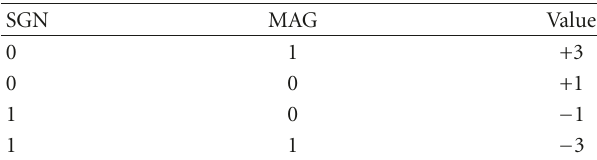
Table 2: Corresponding output signal. Table 3: Experiment results for PRN 11(SAM detection threshold =